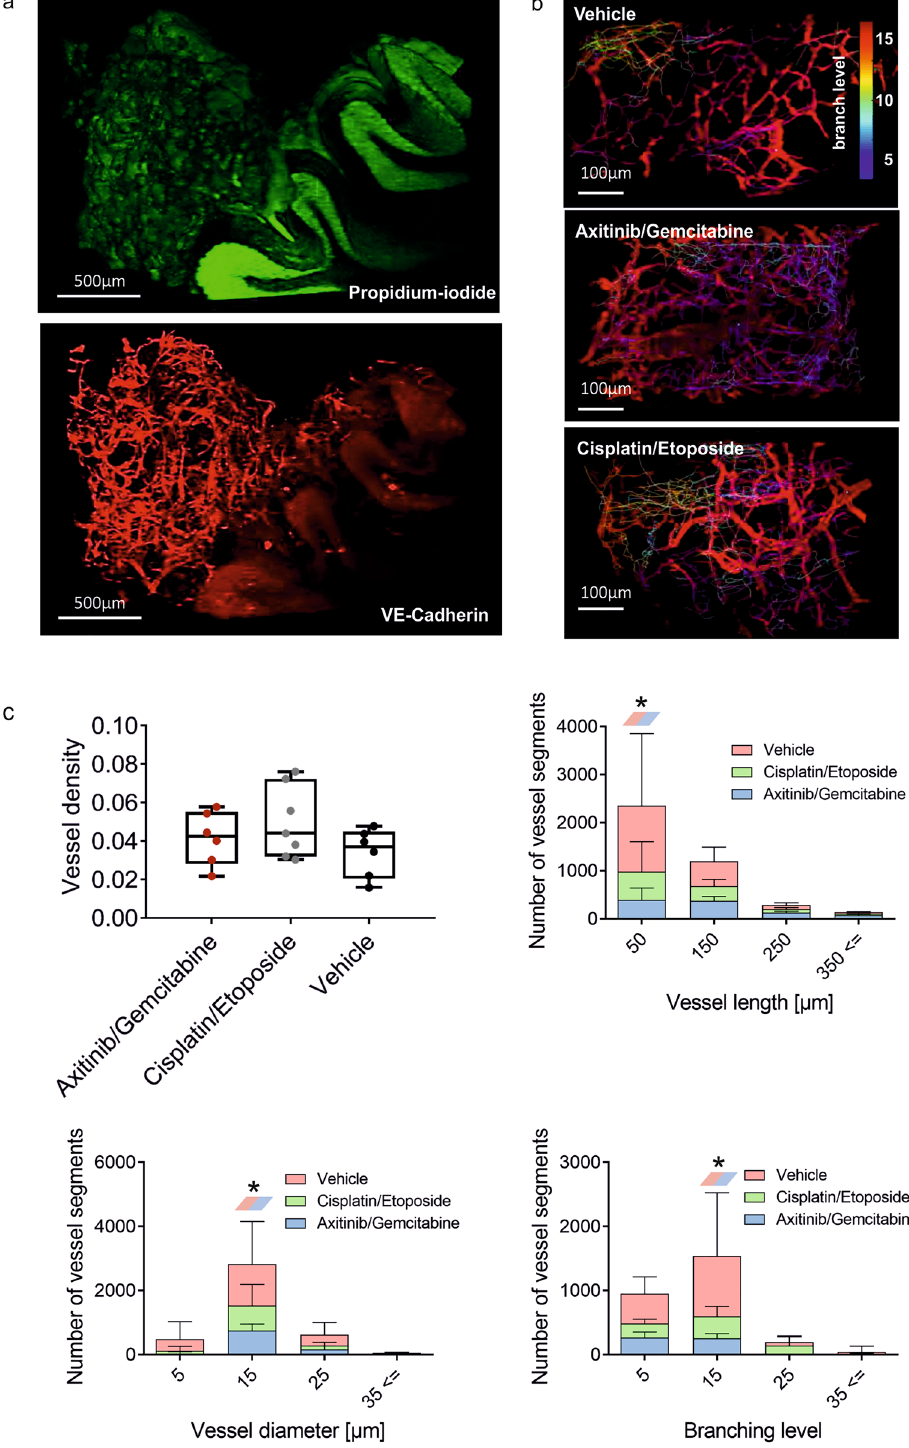
Figure 7. Blood vessel visualization and quantification in an orthotopic group 3 medulloblastoma with 3D-LSFM. At the endpoint of the experiment, blood vessels were stained in vivo with anti-VE-Cadherin Alexa Fluor 647, 30 min before transcardial perfusion of mice. Stained and optically cleared brain samples were imaged with a home-built LSFM. ( a ) 3D reconstruction of orthotopic medulloblastoma in the murine cerebellum after detection of propidium iodide (green) and VE-Cadherin (red) with a 5 × objective (scale bar: 500 µm). ( b ) Blood vessel structure and filament analyses of vasculature in orthotopic tumors after different treatment regimens (scale bar: 100 µm). Vasculature segments are color coded based on branch level. ( c ) Quantitative analysis of overall blood vessels density, vessel length, diameter and branch level distribution under different treatment conditions. Bar graphs present mean ± SD, n = 3, vessel length: Gemcitabine/Axitinib vs vehicle, * p = .047, vessel diameter: Gemcitabine/Axitinib vs vehicle, * p = .042, branching level: Gemcitabine/Axitinib vs vehicle, ** p = .009